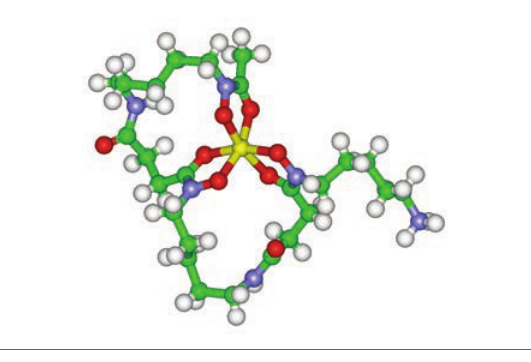
Figure 4. Ferrioxamine B ( Λ -C-trans,trans conformation).